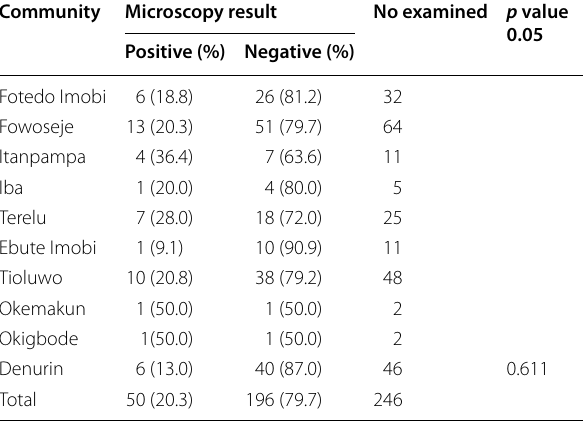
Table 3 Prevalence of lymphatic filariasis in Imobi, Ijebu